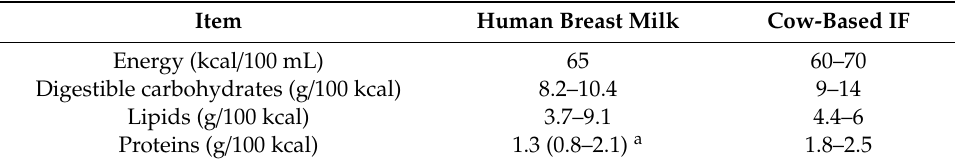
Table 3. Comparison of human breast milk and cow-based infant formula composition (in terms of energy and macronutrients). Data are from the European Food Safety Authority (EFSA) Journal, 2014